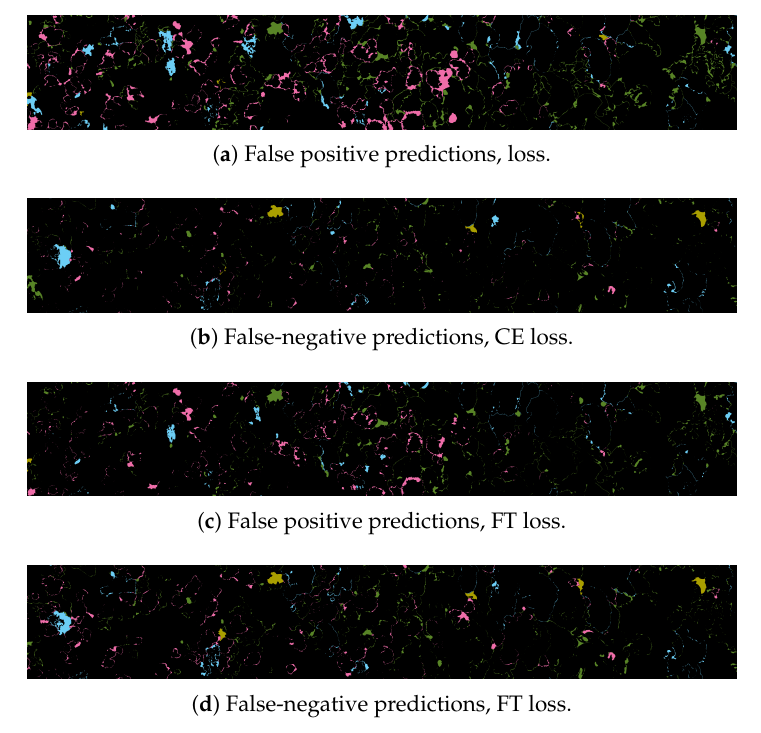
Figure 7. ( a , b ) The CE minimization outputs a model predicting a high number of false positive and labels with smoother shapes. ( c , d ) The FT loss model has a better balance between false positive and false negative, and produces shapes with sharper profiles. However, the encrusting Montipora colonies are almost entirely misclassified.